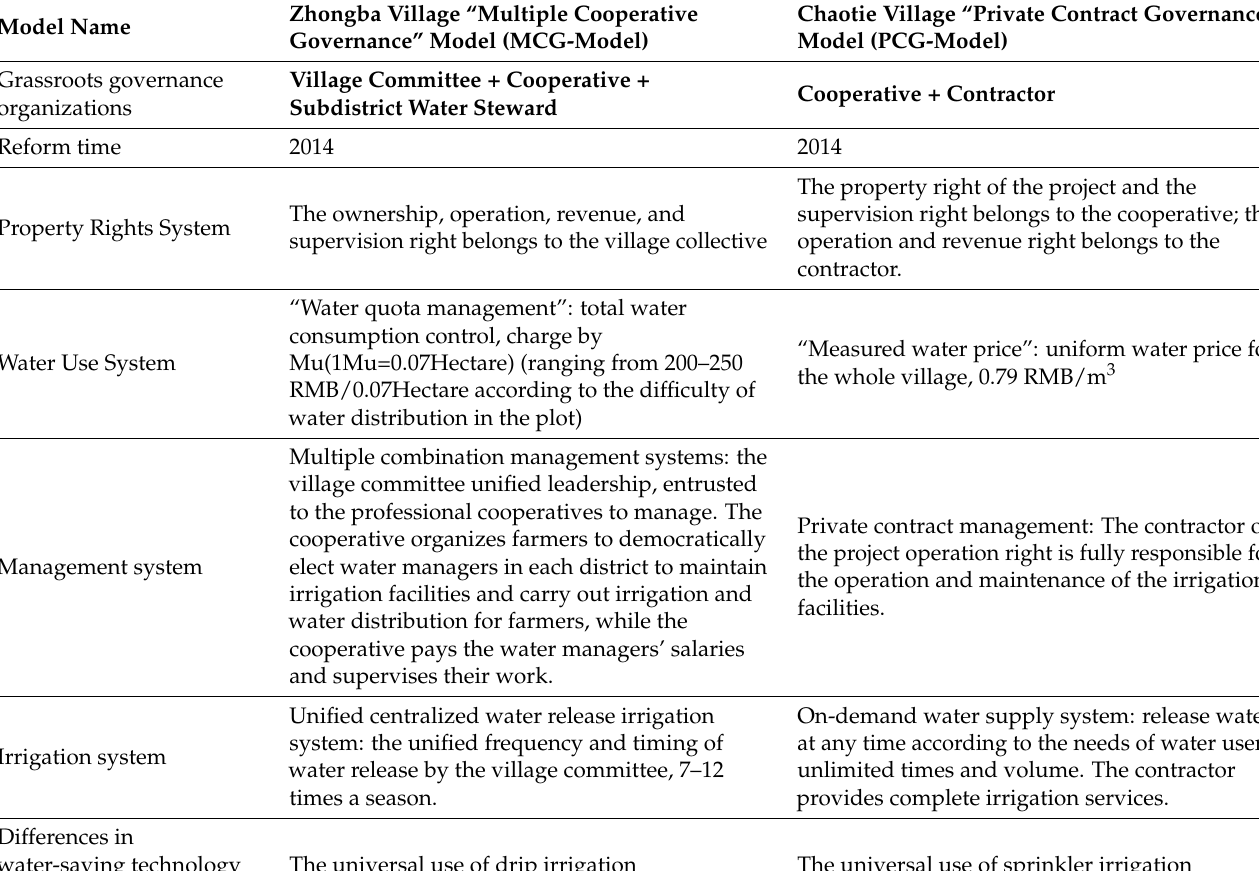
Table 1. Brief description of the differences between the two property rights models in Lu Liang County, Yunnan,